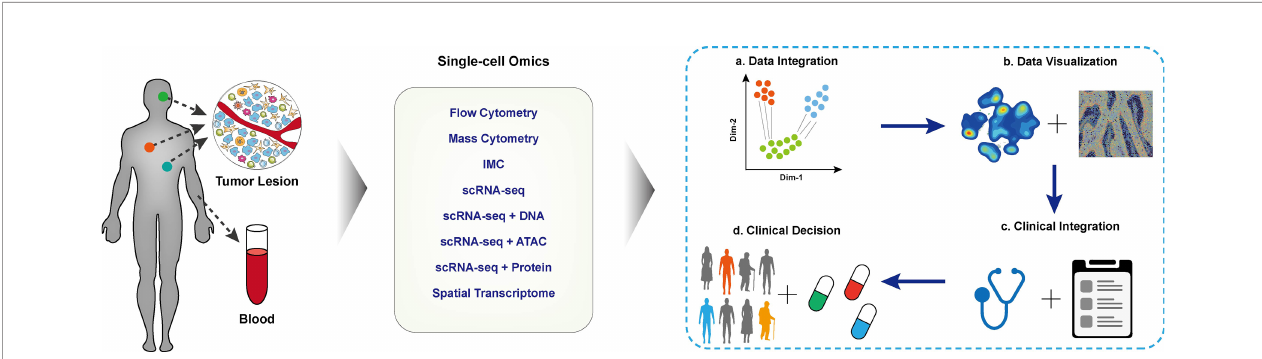
FIGURE 2 | Applications of single-cell techniques in clinical cancer research. The schematic diagram of cancer research with single-cell techniques, blood or tissue samples of the designated patient cohort was collected and performed single-cell pro fi ling. The collected data were integrated for downstream analysis and visualization. With in-depth integration with clinical characteristics, biomarkers for clinical decisions, disease prognosis, and tumor